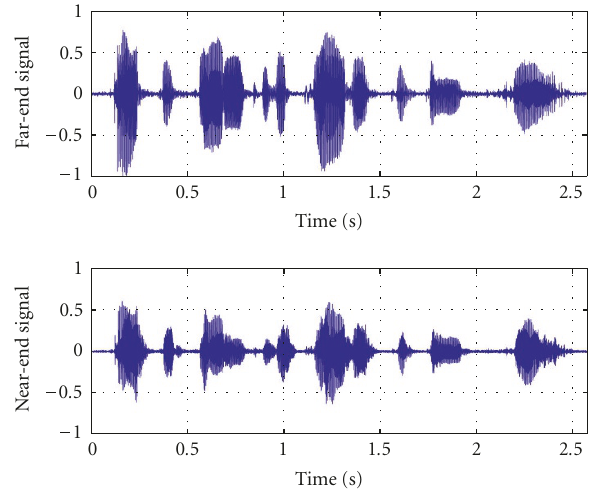
Figure 10: Far-end signal and near-end signal of AEC with speech as excitation.